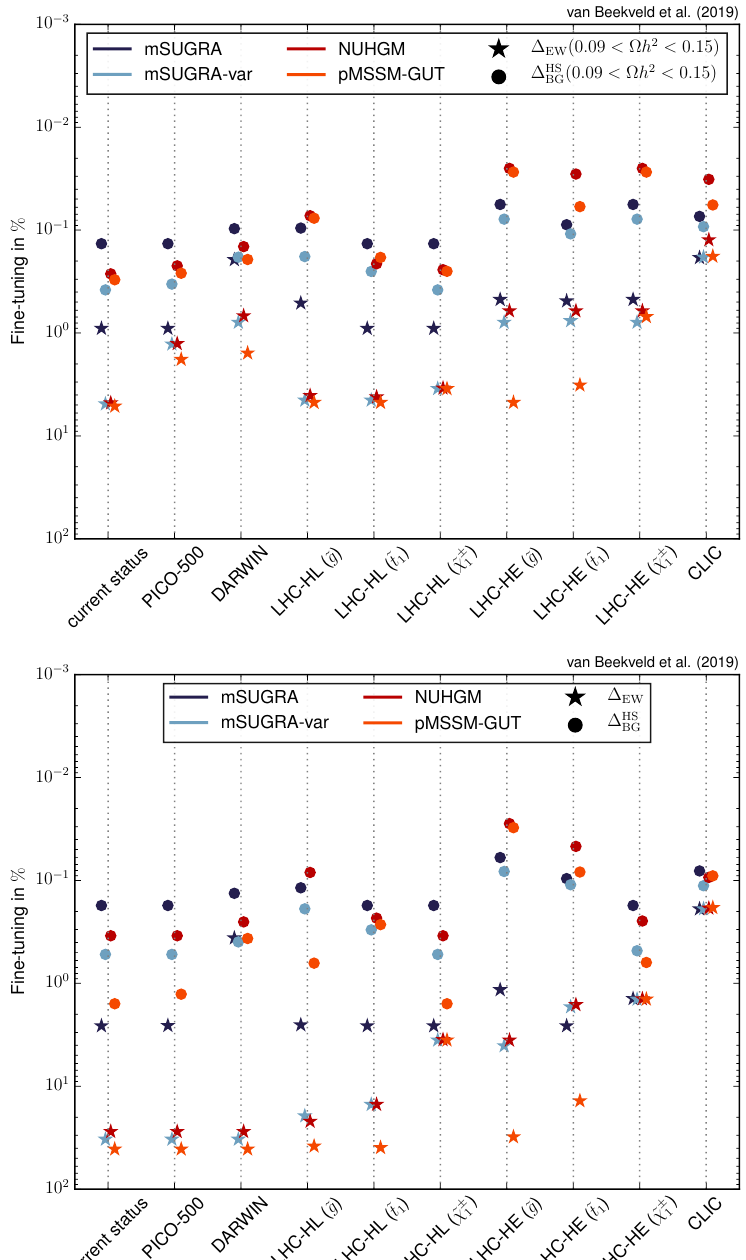
Figure 16 . Summary of the high-scale models and minimal amount of FT still allowed after various future experiments with (top) and without (bottom) the requirement that 0 : 09 < (cid:10) h 2 < 0 : 15. The star (circle) shows the result for (cid:1) EW ((cid:1) HS ). The colors indicate various high-scale models, where BG dark blue indicates mSUGRA, light blue indicates mSUGRA-var, red indicates NUGHM and orange indicates